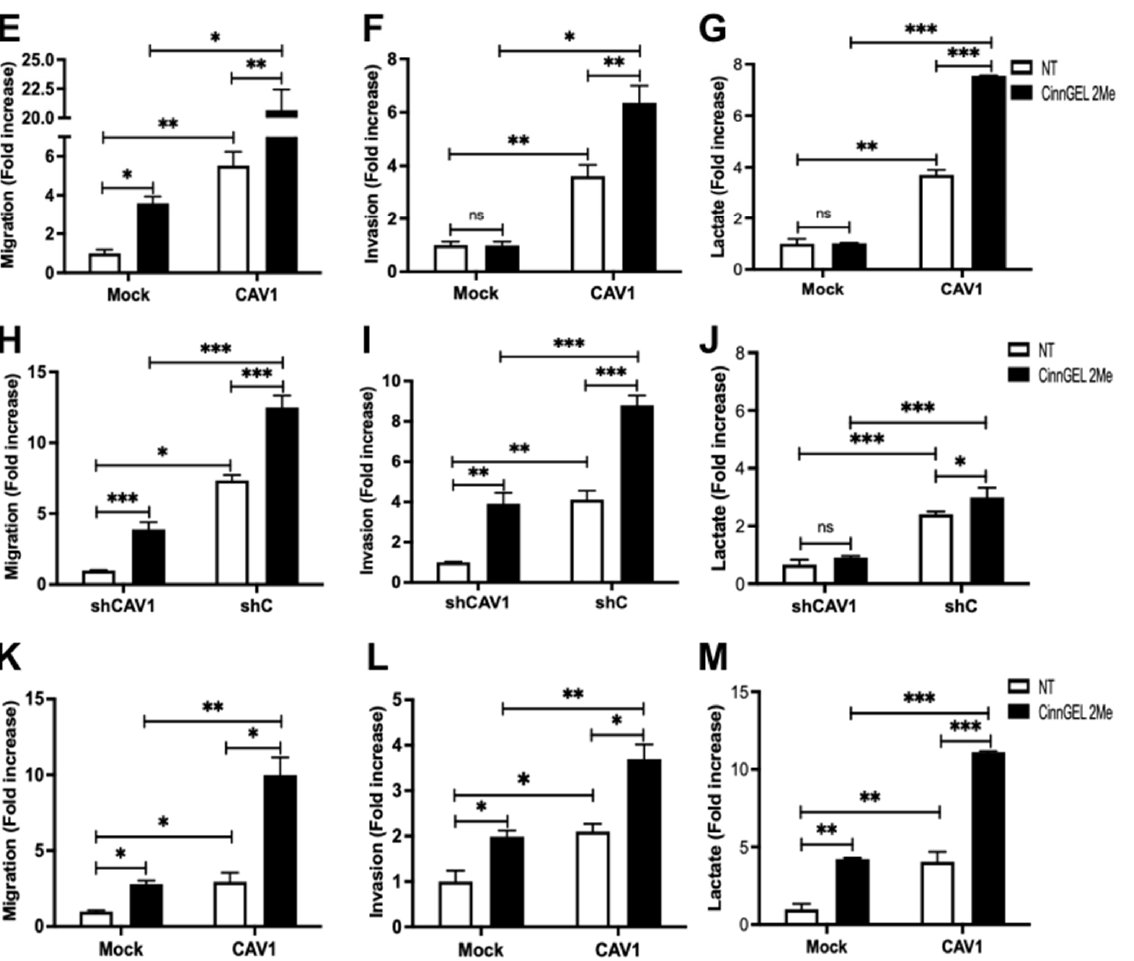
Figure 6. Inhibition of PTP1B activity enhances cell migration, invasion, and lactate production by increasing CAV1 phosphorylation. ( A ) CAV1 was immunoprecipitated from protein extracts containing 2 mg of total protein obtained from B16F10(Mock) and B16F10(CAV1) cells using a polyclonal antibody against CAV1 (2.5 µ g per condition). An immunoblot with the total protein input in each experiment is included in the panel to the right. ( B ) B16F10(Mock) and (CAV1) were treated for 12 h with 5 µ mol/L CinnGEL 2Me. Total protein extracts were prepared and analyzed by Western blotting with antibodies against CAV1, pY14-CAV1, and β -actin. Western blots representative of results obtained in three independent experiments are shown for A and B. PTP1B was immunoprecipitated from protein extracts containing 2 mg of total protein obtained from B16F10(Mock) and B16F10(CAV1) cells ( C ) treated for 12 h with 5 µ mol/L CinnGEL 2Me or ( D ) with 5 µ M Mito-TEMPO for 2 h or 4 mM N-acetylcysteine (NAC) for 4 h using a polyclonal antibody against PTP1B (2.5 µ g per condition). The immunoprecipitates were resuspended in 50 µ L of acetate buffer (pH 5.6), and p-nitrophenyl phosphate was added. Then, the samples were incubated at 37 ◦ C, and absorbance was measured at 415 nm. B16F10(Mock), B16F10(CAV1), MDA-MB-231(shCAV1), MDA-MB-231(shC), HT29(US)(Mock), and HT29(US)(CAV1) were treated for 12 h with 5 µ mol/L CinnGEL 2Me. Then, ( E ) B16F10 cells (2 × 10 5 ) ( H ) MDA-MB-231 or ( K ) HT29(US) were seeded